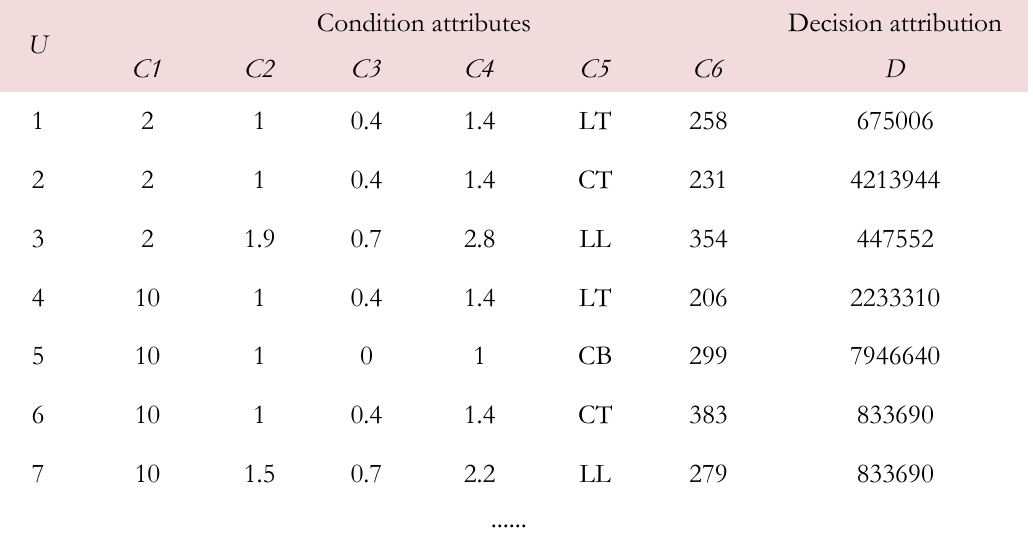
Table 6: Part of the decision table